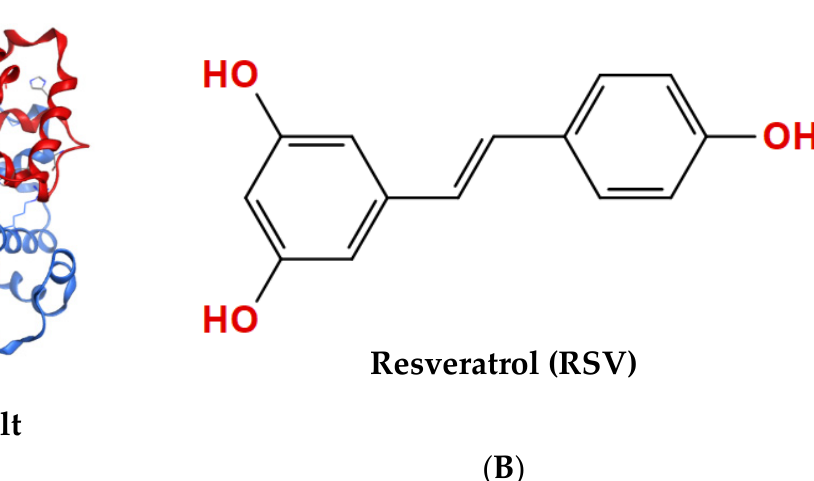
Figure 1. Structures of proteins and compounds. ( A ) Tetrameric structure of hemoglobin of adult (PDB 1GZX) with two α -chains shown in red, two β -chains shown in blue, and heme shown in green. ( B ) Molecular structure of resveratrol (RSV), CAS: 501-36-0.